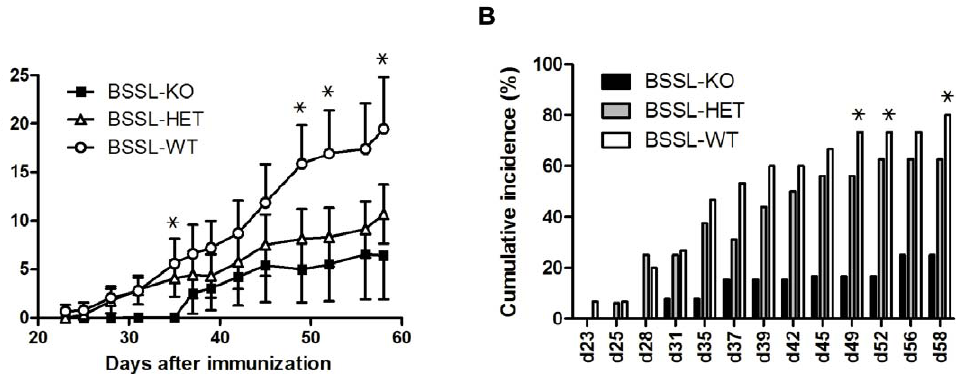
Figure 4. Collagen-induced arthritis in BSSL-KO, BSSL-WT, and BSSL-HET mice. Littermates of male BSSL-KO (n=13), BSSL-WT (n=15), and BSSL-HET (n=16) mice were immunized with chick CII on day 0 and boosted on day 21. Arthritis development was followed by blinded clinical scoring 2–3 times per week for 58 days after initial CII injection. (A) Mean clinical score of arthritis severity and (B) cumulative incidence of arthritis (percentage of affected mice with clinical score $ 1) are shown. Error bars indicate 6 SEM. ??? =p ,